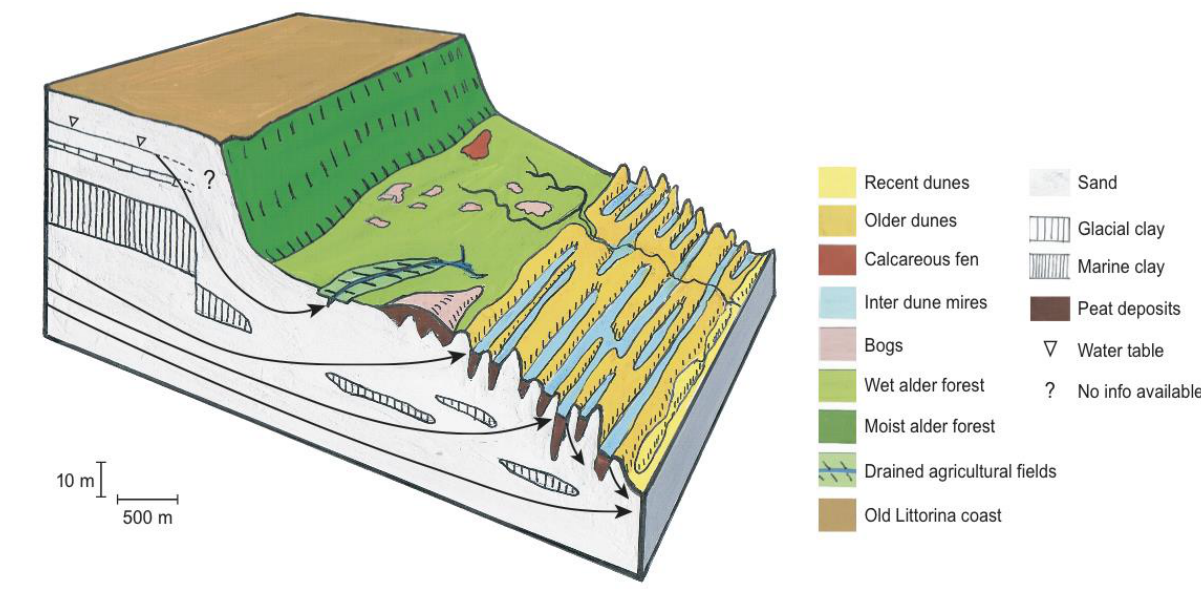
Figure 7. Conceptual model of possible groundwater flow patterns in the transects through Bažu Mire, Kukšupe and Imanta inter-dune